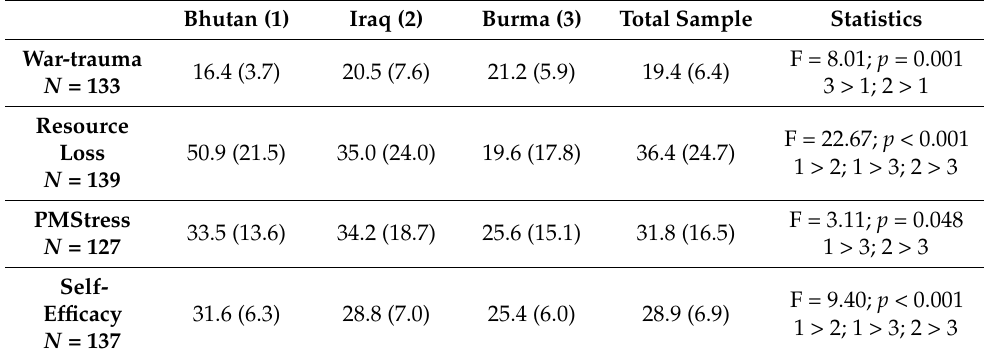
Table 4. War Trauma, Loss, Post-migration stress, and self-efficacy by COU, M (SD). Bhutan